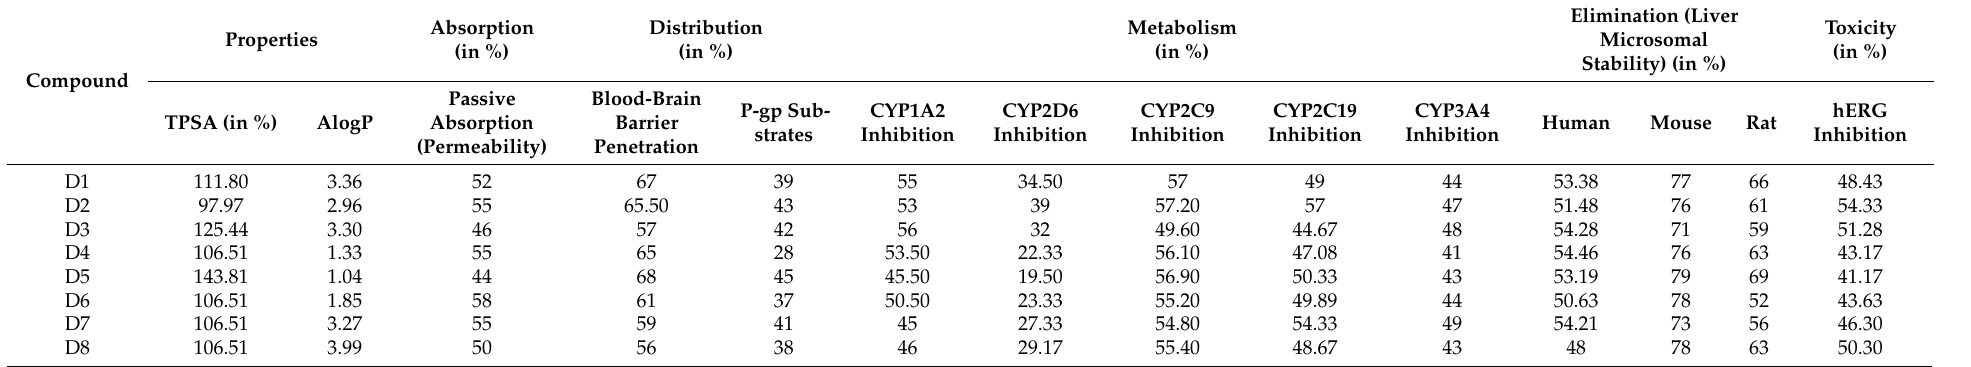
Table 3. In silico ADMET prediction and synthetic accessibility values of designed IRAK4